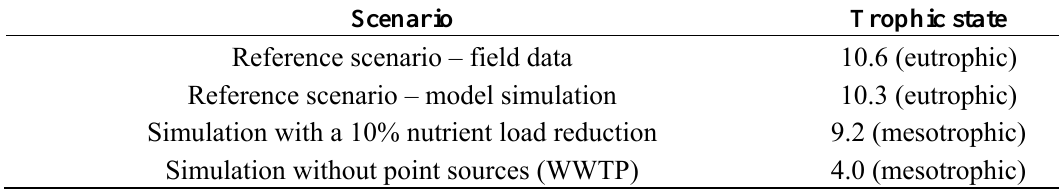
Table 5. Trophic state of the Torrão reservoir for the 1995–2009 period (based on the geometric mean of chlorophyll concentration at the surface, from April to